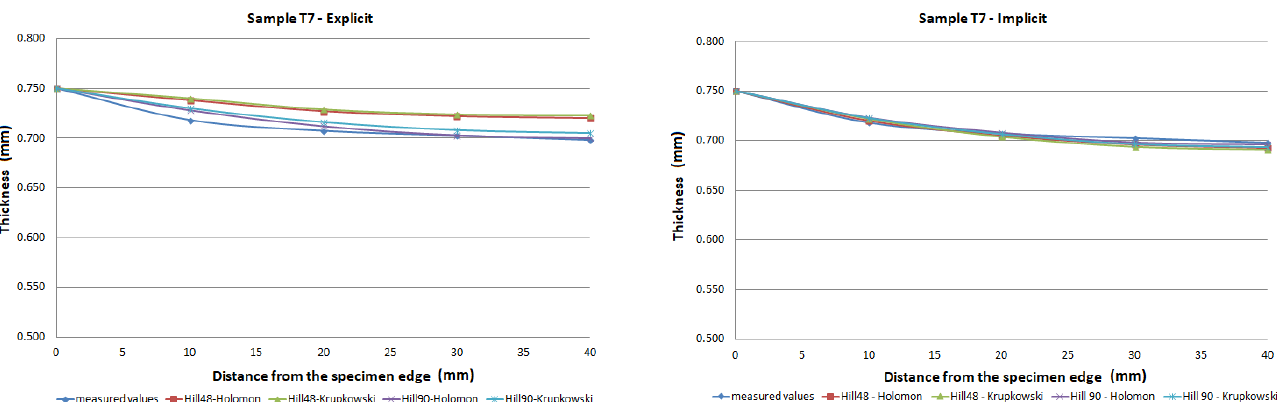
Figure 17. Comparison of predicted and measured thickness values of sample T6 using different types of yield criteria, hardening laws and integration scheme.